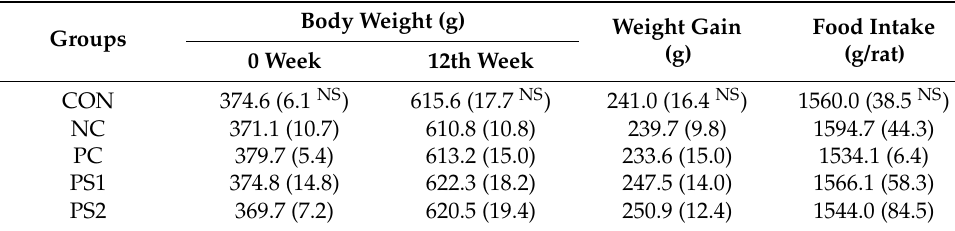
Table 4. Effects of PS on the final body weight, body weight gain, and food intake in the surgically induced OA